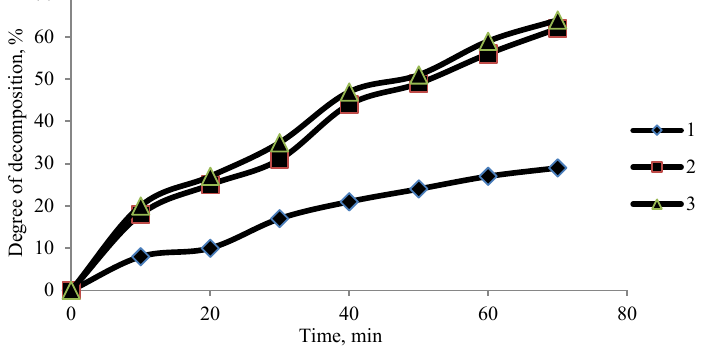
Fig. 4. The dependence of the degree of solution purification from phenol on the duration of the treatment and the ratio ‘simulated solution: anolyte’. Phenol concentration: 0.1 mg/l. Volume ratio ‘simulated solution: anolyte’: 1–10 6 ; 2–5 · 10 5 ; 3–10 5 .